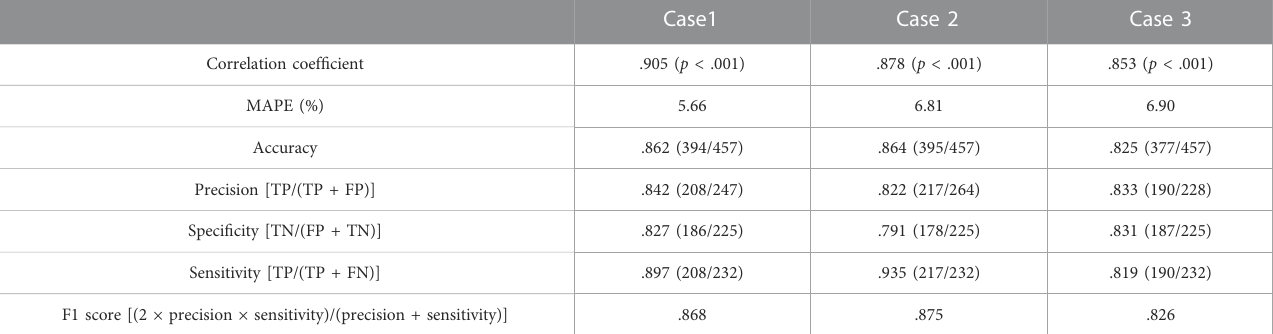
TABLE 2 Estimation test results and diagnostic scores for Case 1, Case 2, and Case 3. The estimation performance metric includes correlation coef fi cients and mean absolute percentage error (MAPE). The diagnostic performance metric includes accuracy, precision, speci fi city, sensitivity, and F1 score. Here, TP and FN denote true positiveandfalsenegative,respectively,